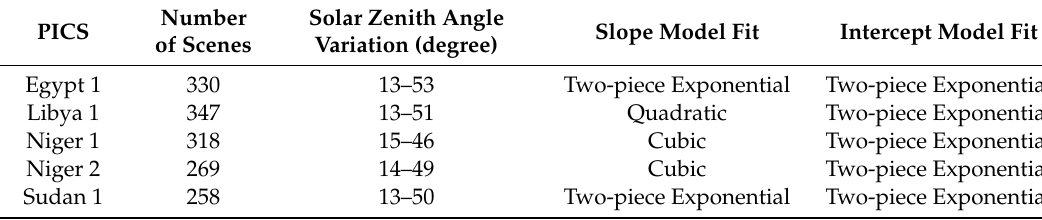
Figure 3. MODIS Solar Zenith Angle Slope Prediction Model as a function of wavelength. Table 2. Hyperspectral model of BRDF slope and intercept as functions of solar zenith angle.